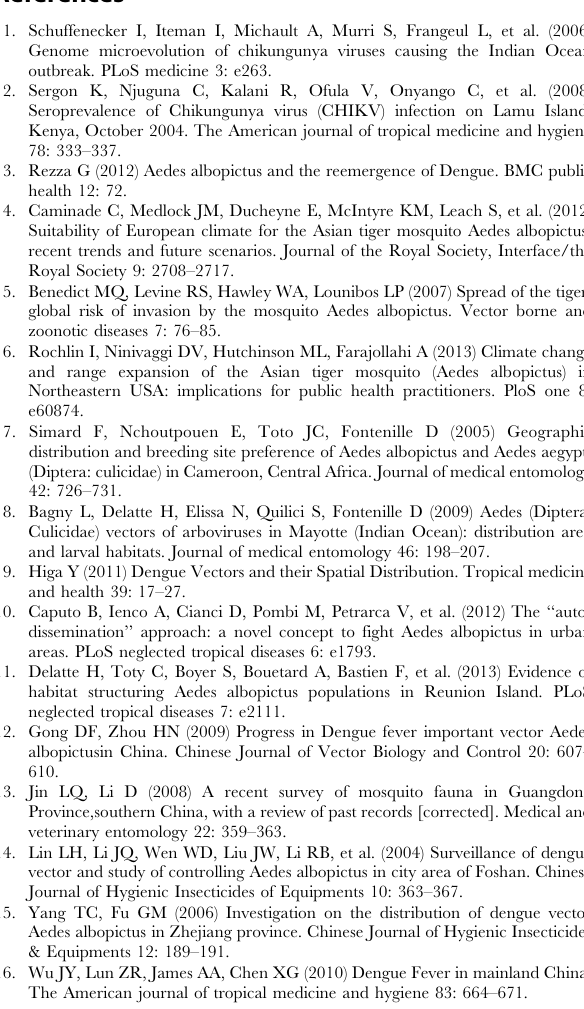
Table S2 Life table analysis of Ae. albopictus adults. Note: Values are the mean 6 standard deviation. Values in the same column connected with the same letter indicate a significant difference at the 5% level within the same experimental group. File S1 Original data of the manuscript. Data used for making the figures and tables for the